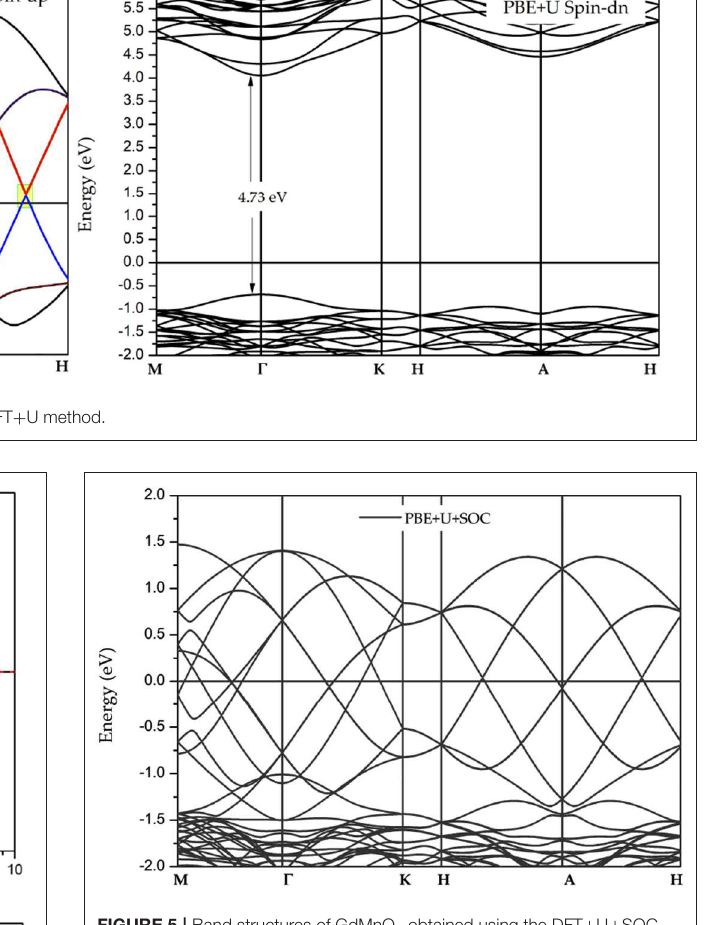
FIGURE 5 | Band structures of GdMnO 3 obtained using the DFT + U + SOC